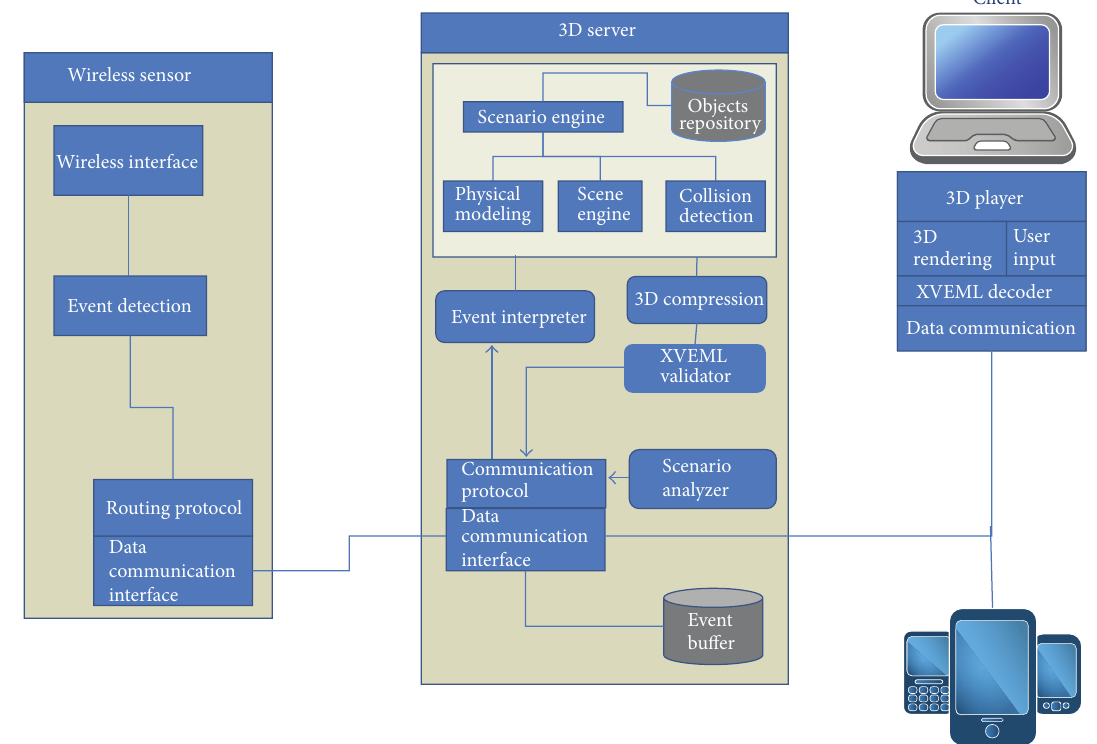
Figure 1: The overall system